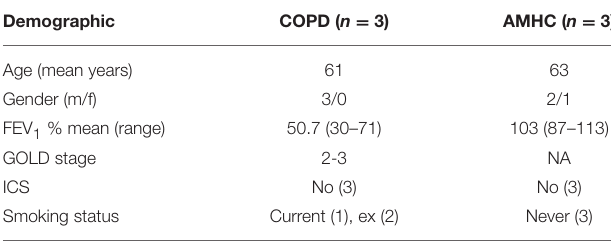
TABLE 1 | Demographics of individuals with COPD and AMHC